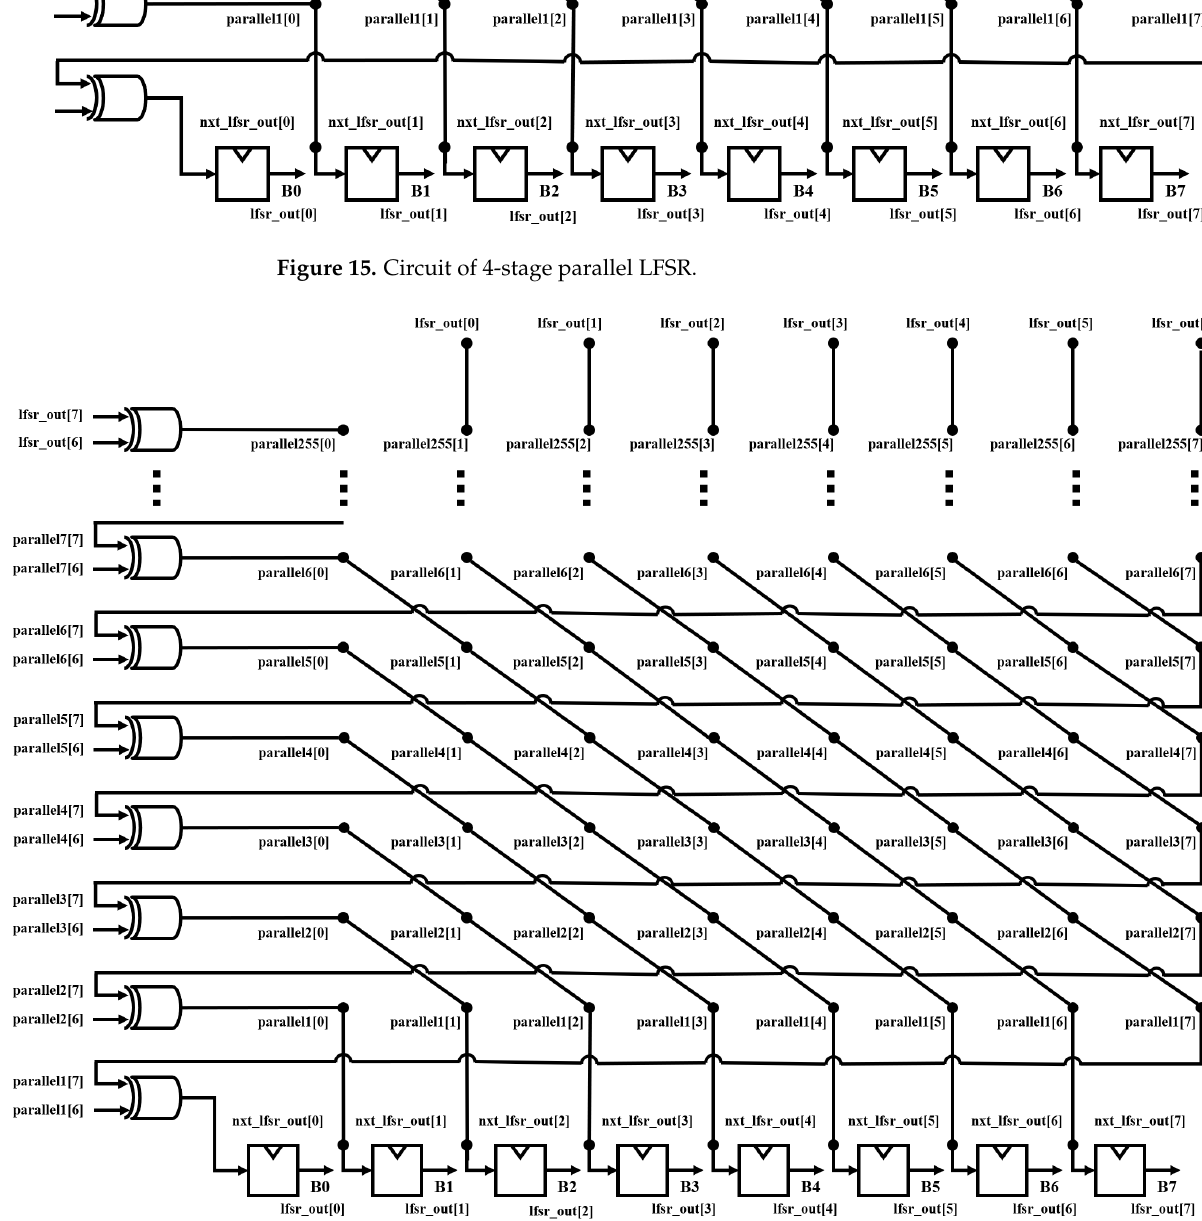
Figure 16. Circuit of multi-stage parallel